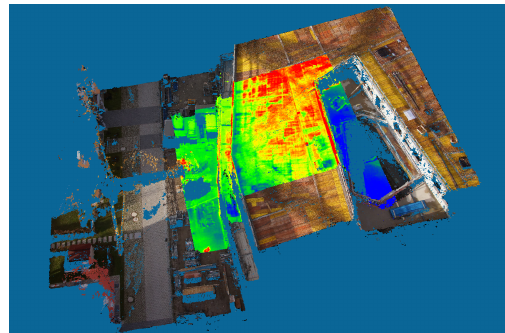
Figure 4. Overlay of RGB image and coregistered TIR image